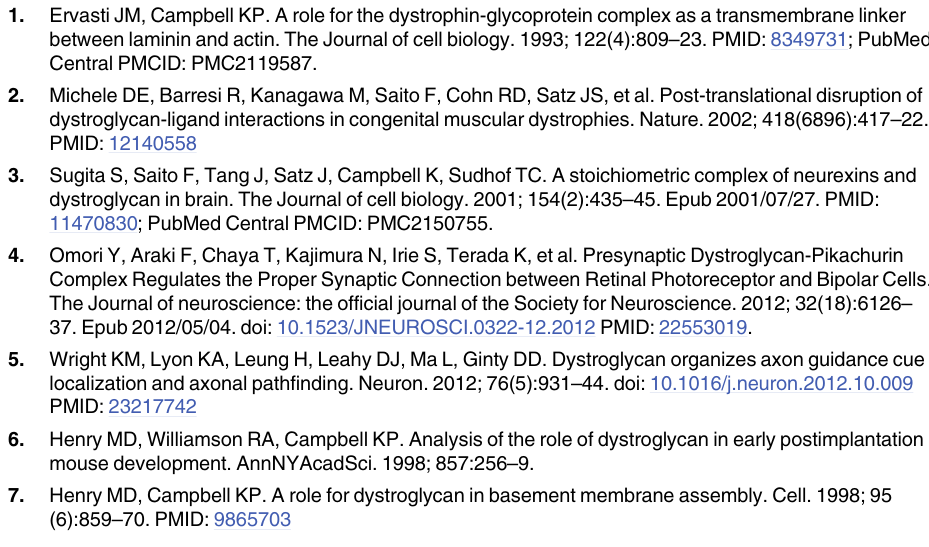
LARGE mice. Bars represent 200 μ m. White boxes: image subsections shown in Fig 4 (see myd main text). (TIF) cerebellar defects. Cerebellar sections of S2 Fig. LARGE-LV5 transgene corrects LARGE myd and LARGE -LV5 mice (as indicated). a-d : brains from wild type, WT-LV5, LARGE myd myd Haematoxylin/Eosin staining. In WT and WT-LV5 mice (a, b), the molecular layer (Black arrowhead) and granular cell layer (White arrowhead) are readily apparent, with a single layer mice (c), the granular cell of large Purkinjie cells sandwiched between them. In LARGE myd layer is extensively disrupted with large aggregates of ectopic granule cells superficial to the molecular layer (asterisks). This disruption is corrected, and ectopic granule foci greatly -LV5 mice (d). e-h : IIH6 immunostaining. IIH6 reactivity is reduced, in the LARGE myd -LV5 cerebellum, but observed in blood vessels and the pia in WT, WT-LV5 and LARGE myd not in brains of LARGE mice. Overall stain intensity is higher in LV5 transgenic mice than myd in WT controls. i-l : β -DG immunostaining. Pia and blood vessels are visible in the cerebellum -LV5 mice but not in LARGE mice. LARGE mice of WT, WT-LV5 and LARGE myd myd myd instead display a diffuse, indistinct staining of the molecular layer. Bars represent 200 μ m. White boxes: image subsections shown in Figs 5 and 6 (see main text). (TIF) S3 Fig. LARGE-LV5 transgene confers IIH6 reactivity upon testis. IIH6 western blot of tis- and LARGE -LV5 mice (as indicated). sue lysates from testis of WT, LARGE myd myd (TIF) S1 Sequences. qPCR primers used for